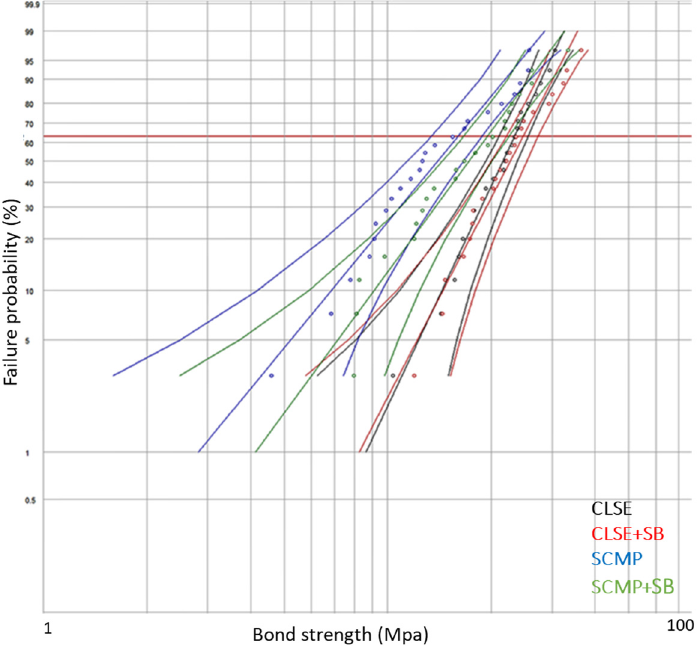
Figure 5. Probability plot, Weibull 95% CI. CLSE, Clearfil SE; CLSE +SB, Clearfil SE + air abrasion;